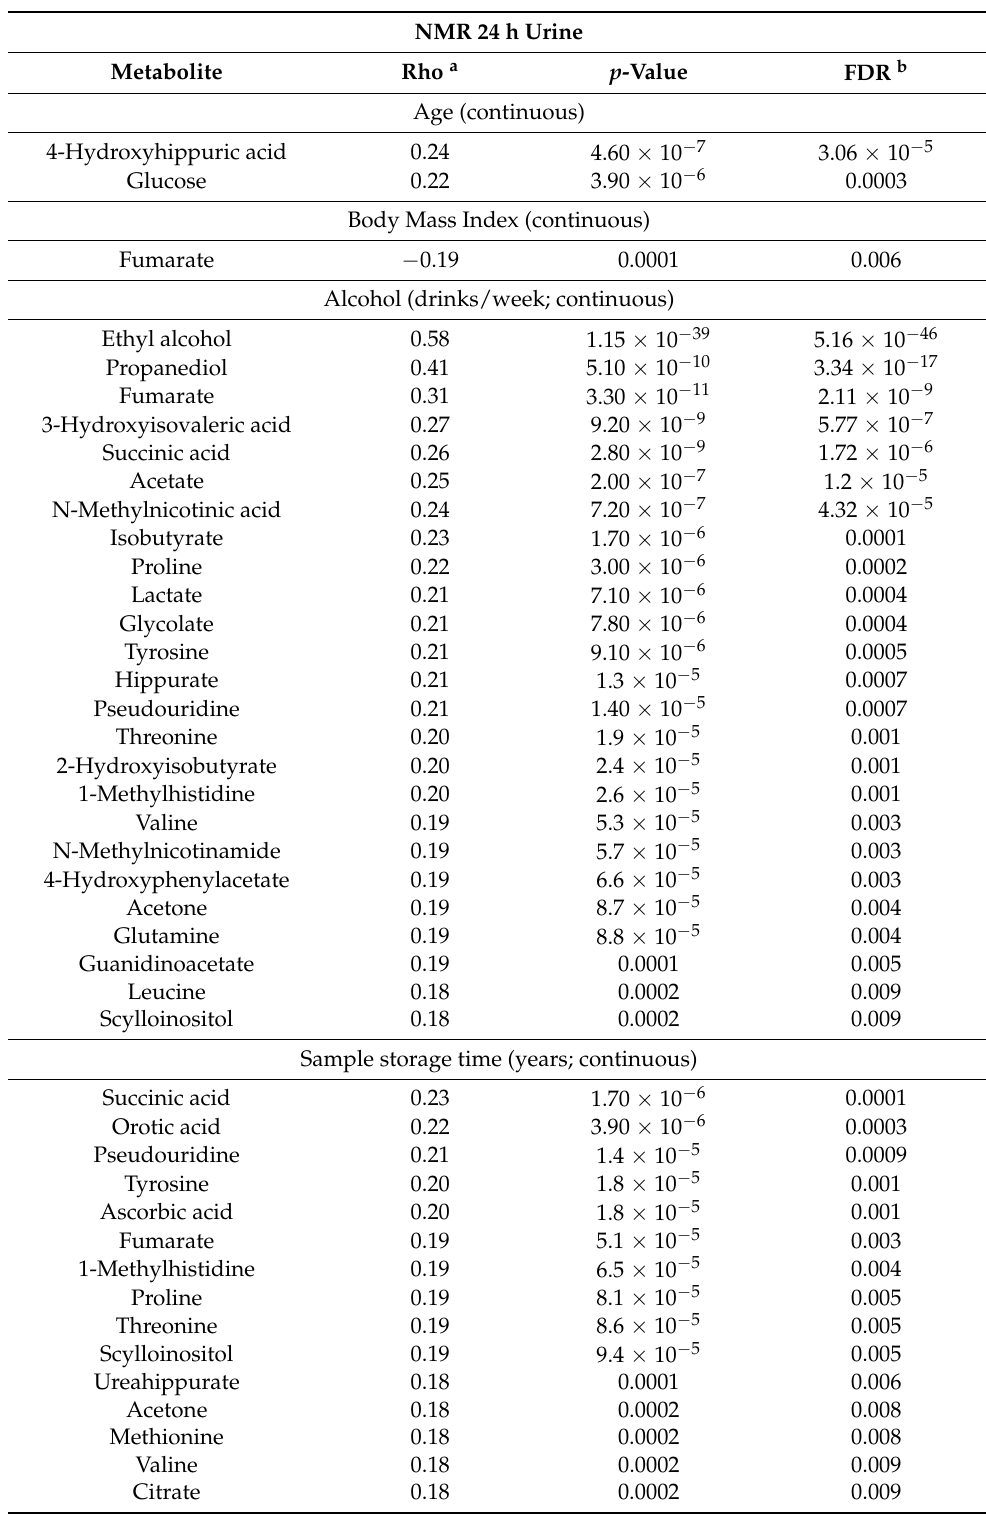
Table 4. Variables correlated with metabolites at FDR < 0.01 by NMR, descending in level of statistical significance within each